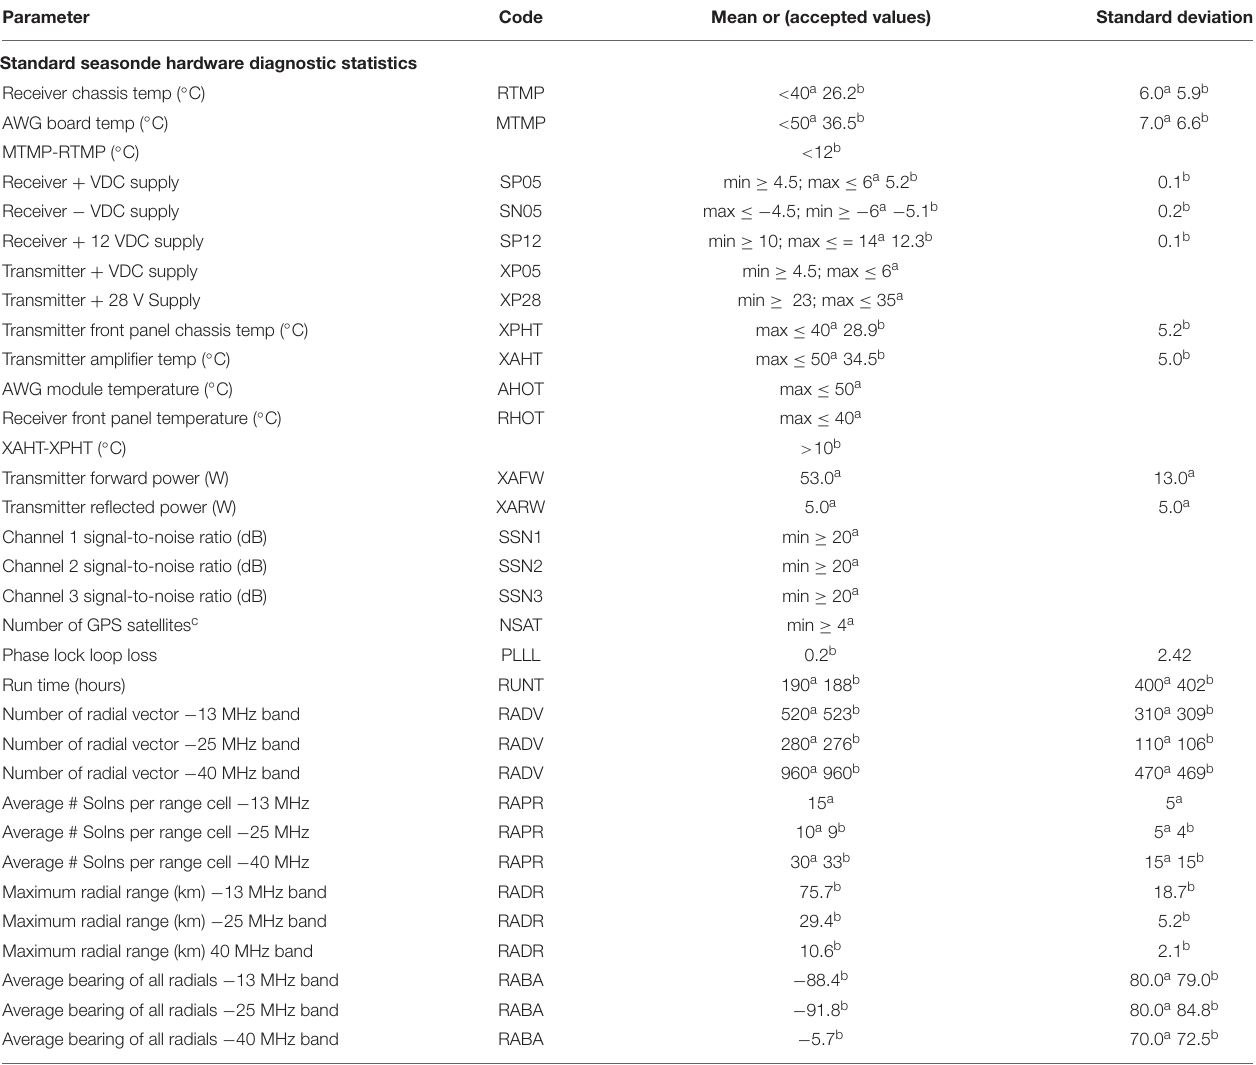
TABLE 5 | Recommended ranges for diagnostic parameters for Codar SeaSonde HFR systems (Emery and Washburn, 2007).